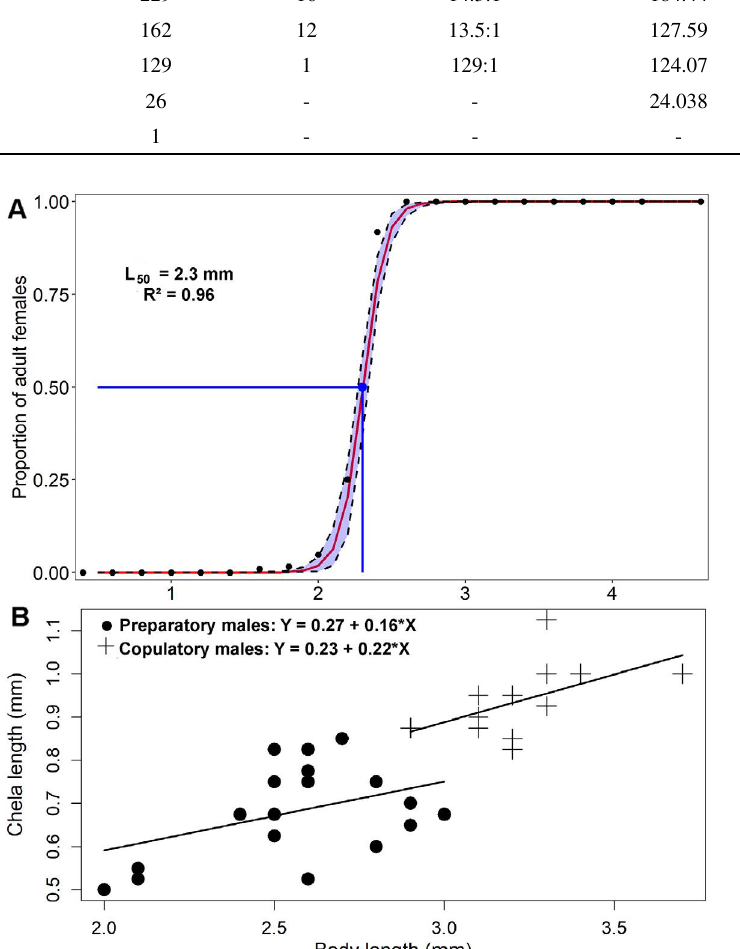
Fig. 5. – A, logistic curve and size at first maturity ( L ) for females of Chondrochelia dubia . Blue envelope represents the 95% confidence 50 interval. B, regression lines indicating morphometric maturity in males of C. dubia